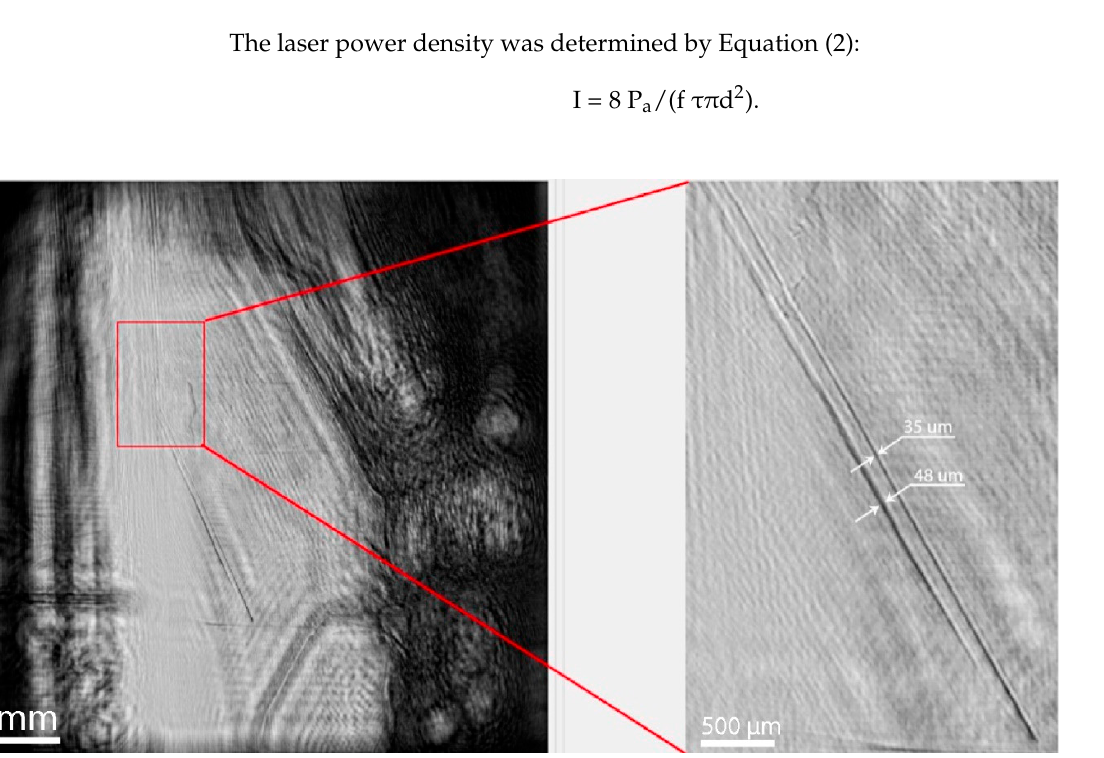
Figure 3. Reconstructed holographic image of GaSe (sample no. 1) in the best focus plane containing images of microcracks ( left ) and their magnified images ( right ).